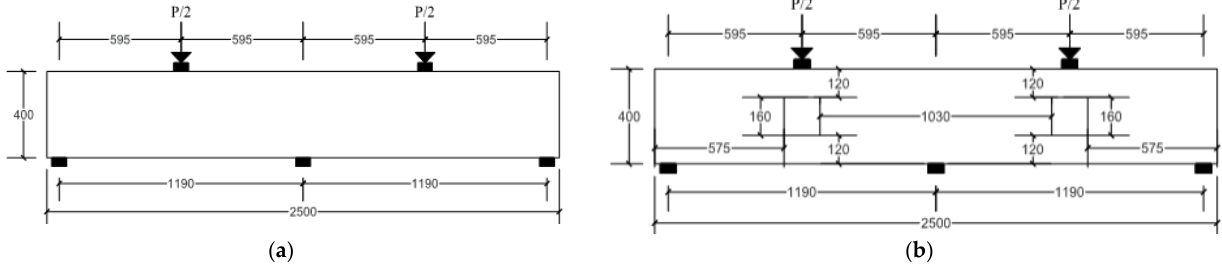
Figure 2. Typical layouts of the tested specimens ( a ) RCCDBs without openings; ( b ) RCCDBs with openings (all dimensions are in mm).